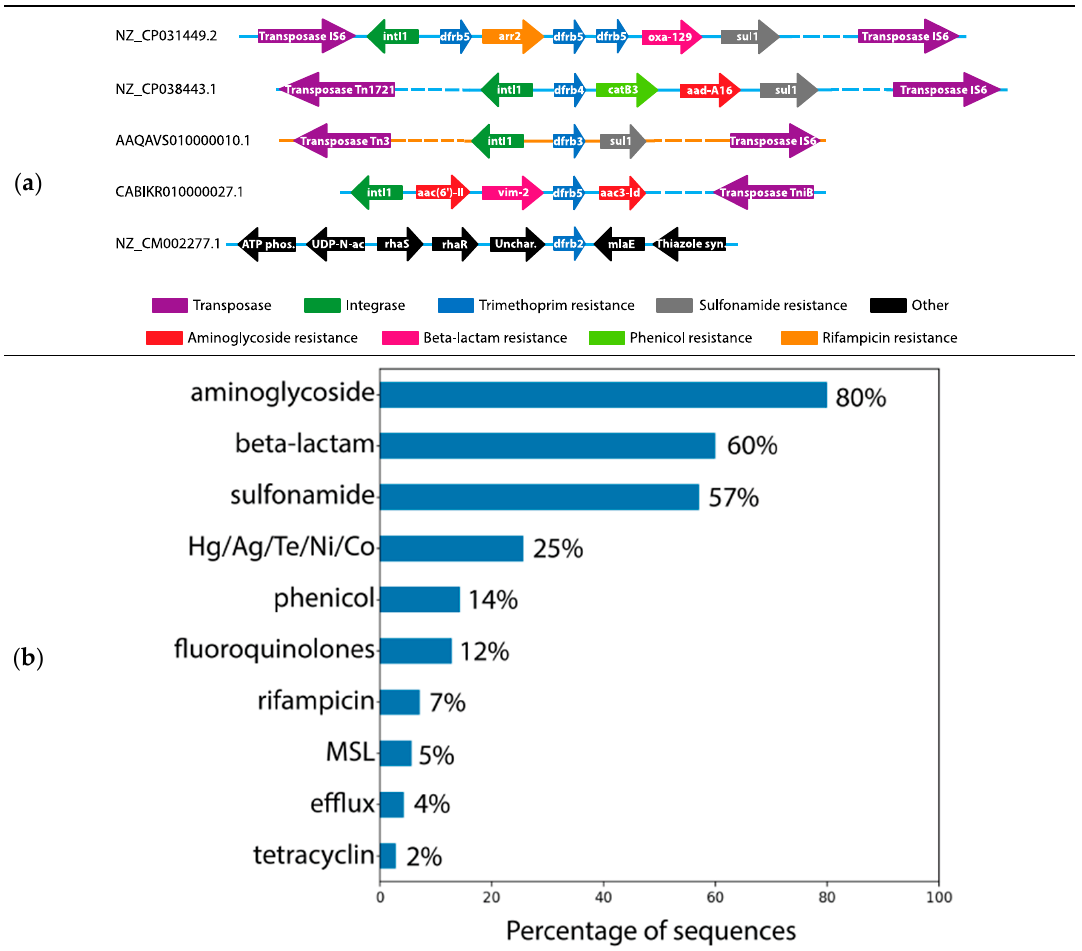
Figure 2. ( a ) Scheme of the genomic context of five representative sequences. Blue lines represent genomic sequences, whereas the orange line represents a plasmid sequence. Dashed lines contain regions that are not represented here. ( b ) Population of dfrb genes accompanied by a gene conferring resistance to another antimicrobial agent, expressed as percentage. MSL: macrolides, streptogramins, lincosamides.